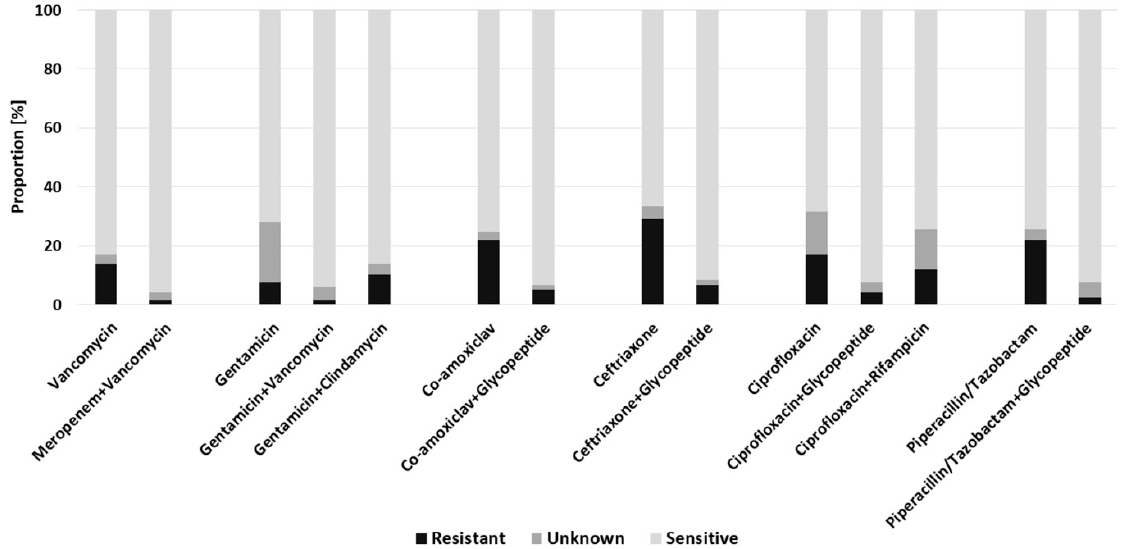
Figure 1. Predicted efficacy of empiric antimicrobial regimens for the whole FRI cohort.